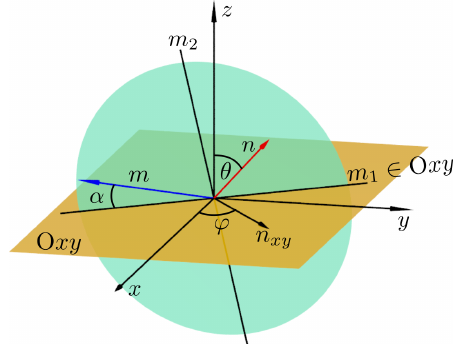
Figure 2. The direction of the applied stress (cid:126) n as a function of polar and azimuthal angles θ , ϕ , and the direction in which the Poisson’s ratio is measured (cid:126) m as a function of α -angle lying in the plane (presented in the form of a green disc) spanned by the vectors m 1 = (cid:126) n are unit